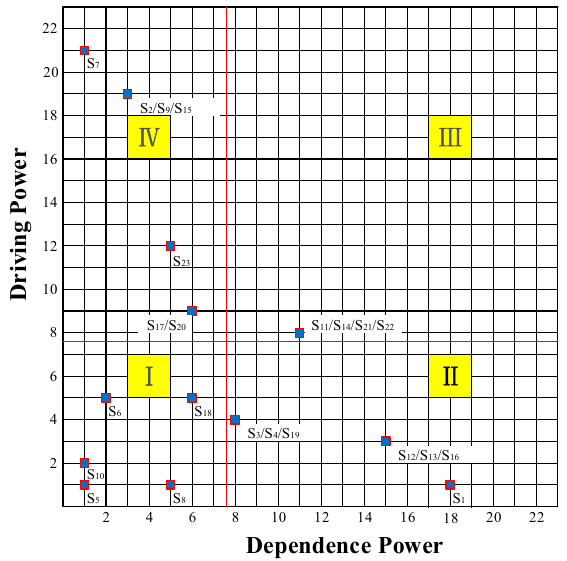
Figure 3. Driving power and dependence power diagram.